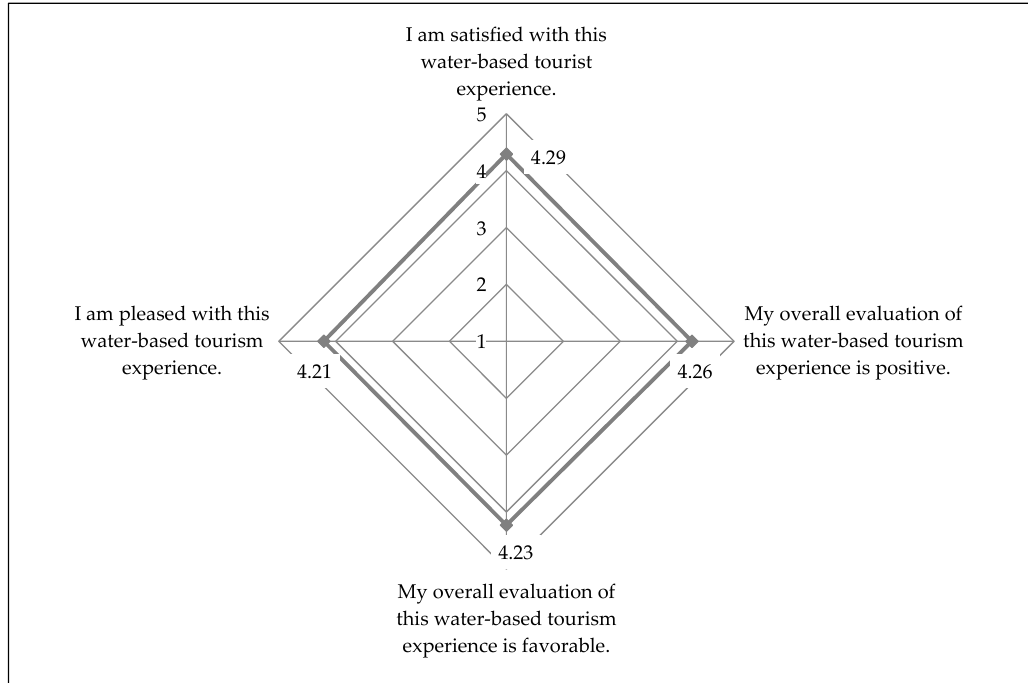
Graph 6. Assessment of the variable Satisfaction with the experience.